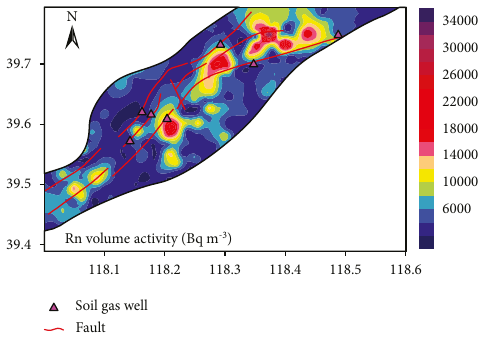
Figure 7: A contour map of soil gas Rn volume activities in the 388 sampling points.